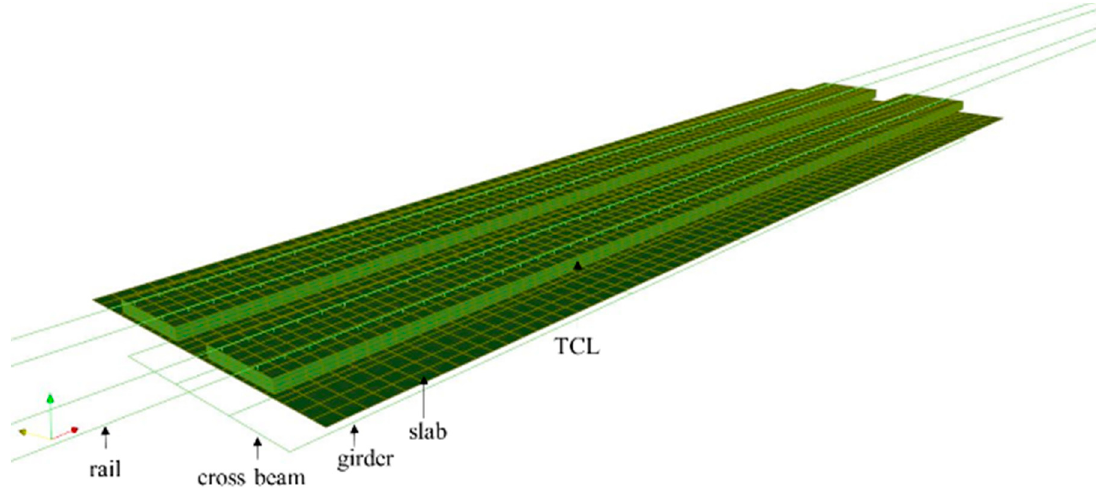
Figure 7. Model of PSC I-girder railway bridge with two traffic lines for moving load analysis.